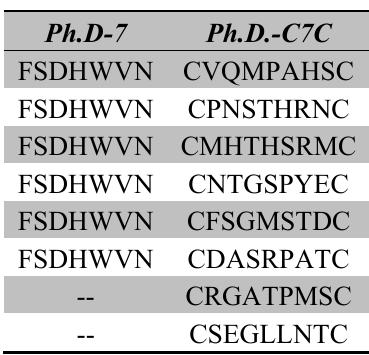
Table 1. Peptide sequences obtained from the Ph.D.-7 and Ph.D.-C7C